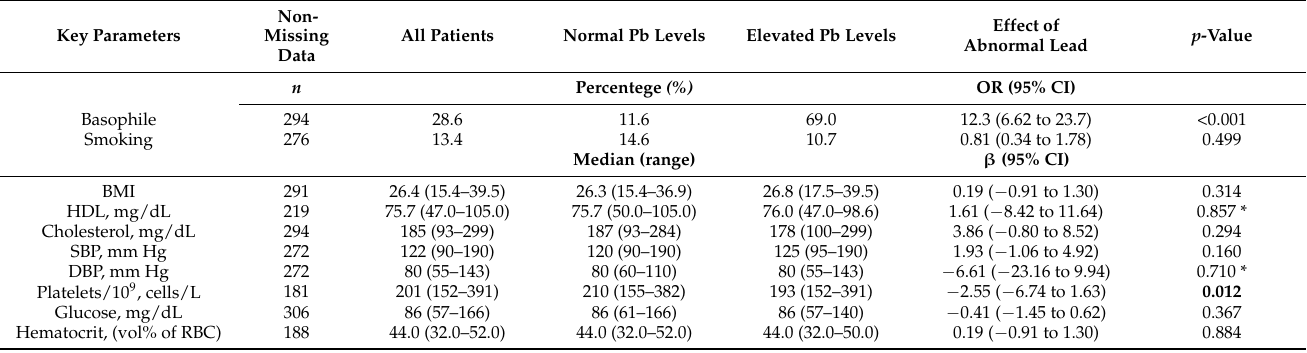
Table 3. Key parameters for the sample of informal workers, stratified by elevated ( ≥ 5 µ g/dL) BLL.